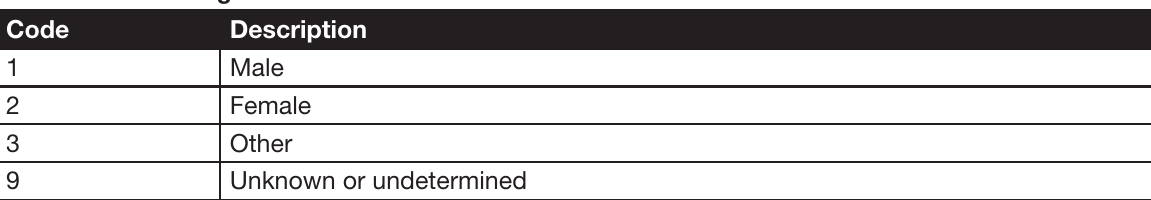
INTIMATE PARTNER VIOLENCE: UNIFORM DEFINITIONS AND RECOMMENDED DATA